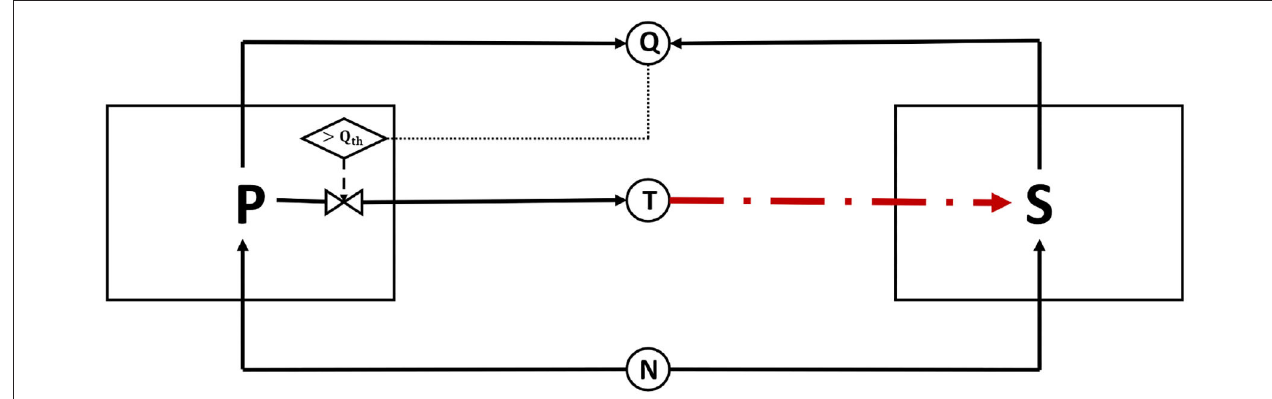
FIGURE 1 | A schematic representation of the model: two bacterial strains, a toxin producer P and a sensitive strain S , are in a competition over nutrient, N . P uses QS regulation to regulate its toxin production; As P grows, it emits quorum signals into its environment. When the quorum sensing molecules concentration exceeds a certain threshold, indicated here by Q th , P switches on its production of toxin T . S is a microbial strain which competes over the same nutrient, N , and is sensitive to the toxin T . In this model, S also produces the same quorum sensing molecules as P to the medium; however, in contrast to P , it does not sense the quorum signals concentration in its environment. The absence of a signal-sensing mechanism at S implies that the quorum signals produced do not act as a source of information for the said strain. However, these signals still interfere with the functioning of the QS system of the P strain. In that sense, the signals produced by S can be termed “dishonest signals,” from signaling theory perspective, as they do not serve to convey true information that is beneficial to the signal receiver.